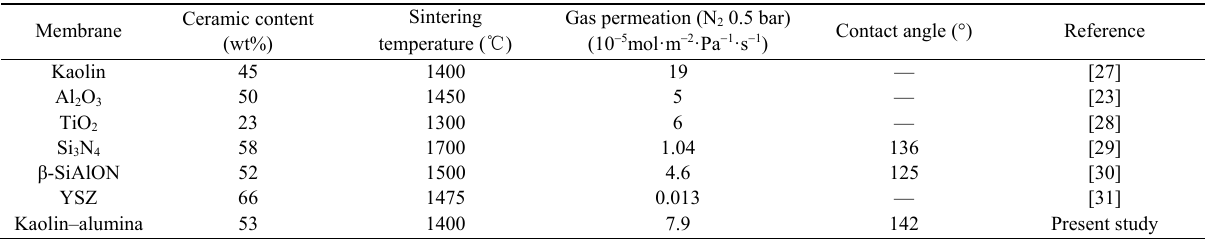
Table 3 Comparison of ceramic membrane gas permeation and hydrophobicity in this study with previous works